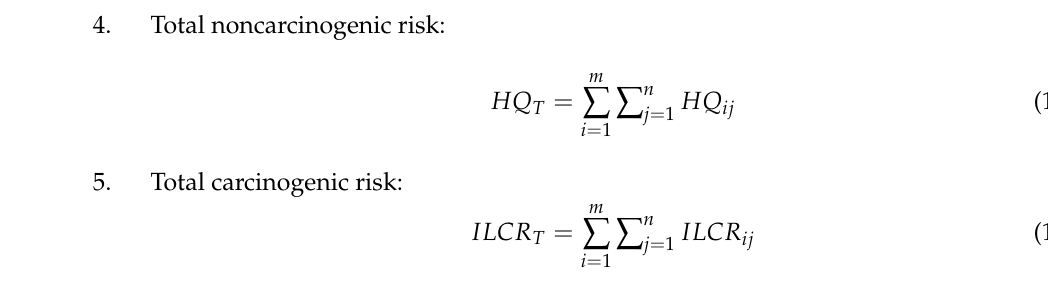
Table 4. Specific values of health risk assessment model parameters.